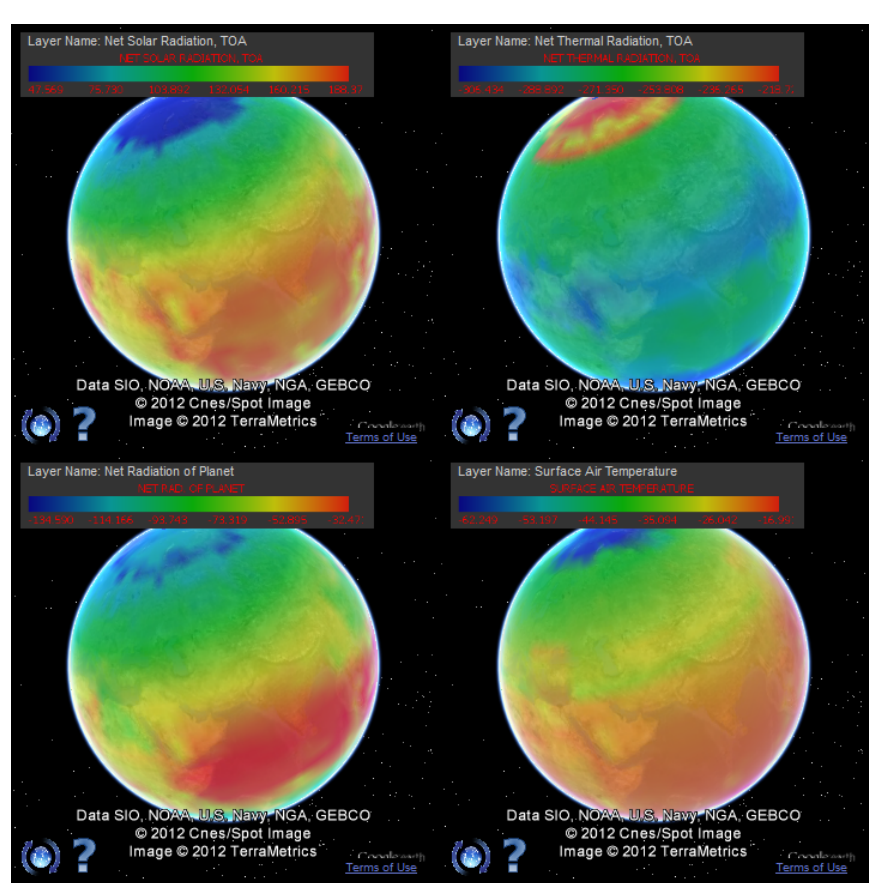
Figure 7. Data exploration on multiple Google Earths